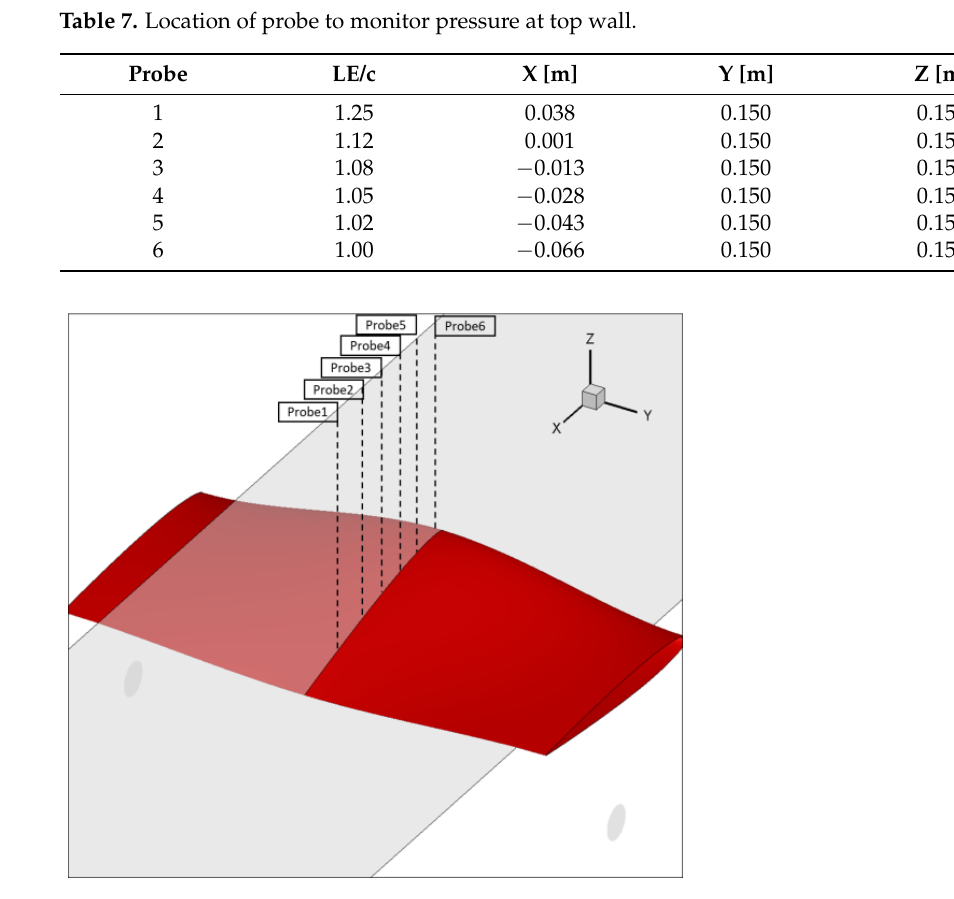
Figure 9. Geometry of Delft Twist11 hydrofoil and location of probes 1 to 6.